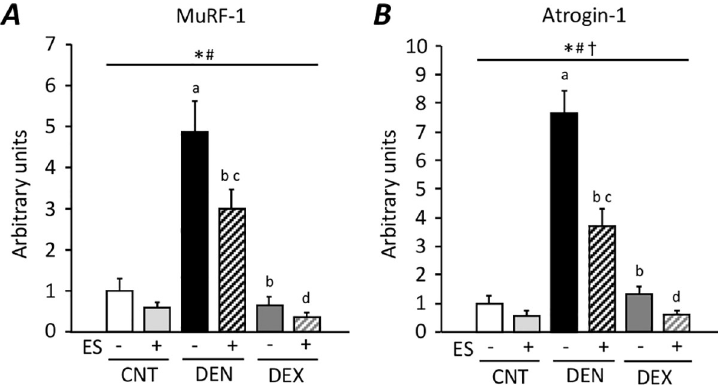
Fig 6. Neuromuscular electrical stimulation (ES) training limits the increase in mRNA expression of ubiquitin ligases in DEN muscles. The expression levels of MuRF-1 ( A ) and atrogin-1 ( B ) mRNA were normalized to the glyceraldehyde-3-phosphate dehydrogenase mRNA and expressed as fold change of the mean CNT value, which was set to 1. Bars show the mean and SEM results from 6–9 muscles per group. Statistical significance was set at P < 0.05: main effect of � treatment (i.e., DEN and DEX) and # ES; † interaction of treatment and ES; difference versus a CNT, b DEN, c CNT+ES, and d DEN+ES.